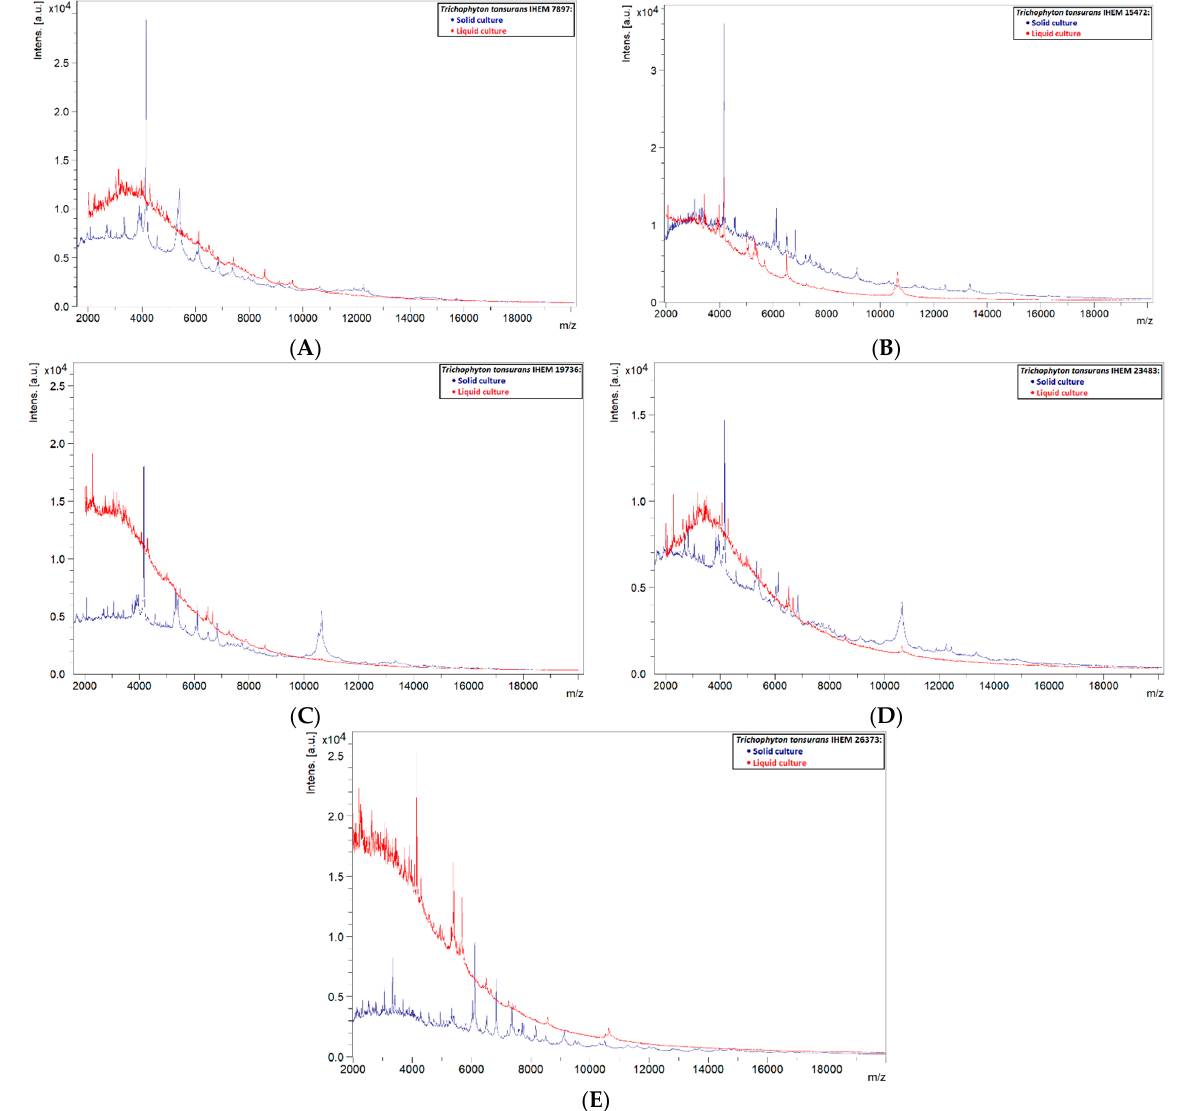
Figure 4. Comparison of solid and liquid cultures of the reference strains used in the liquid database.